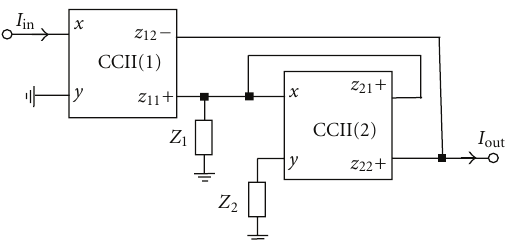
Figure 1: The proposed cascadable current-mode circuit configu- ration.